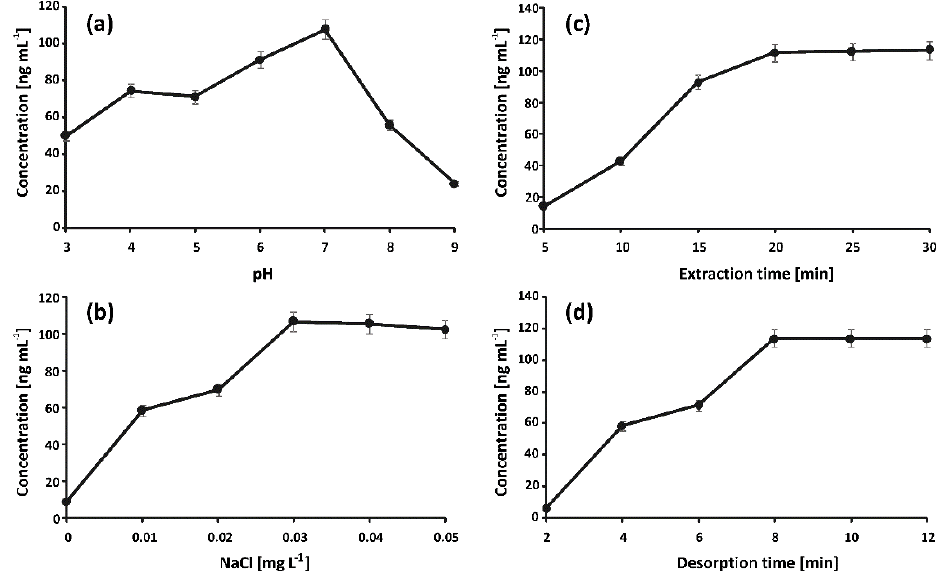
Figure 7. Effect of pH of samples ( a ), amount of NaCl ( b ), extraction time ( c ), and desorption time ( d ) on the performance of the DES-TF-SPME method. The measurements were performed using 200 mL samples containing 125 ng mL − 1 of formaldehyde derivative ( n = 4). Conditions: ( a ) Extraction time 30 min with the addition of 0.05 mg L − 1 NaCl and desorption with a mixture acetonitrile/water (90/10, v / v ) for 12 min. The pH is a variable value. ( b ) Extraction time 30 min and desorption with a mixture of acetonitrile/water (90/10, v / v ) for 12 min. The pH of the sample is adjusted to 7. The amount of NaCl is a variable value. ( c ) Extraction with the addition of 0.03 mg L − 1 NaCl and pH adjusted to 7, desorption with a mixture of acetonitrile/water (90/10, v / v ) for 12 min. The extraction time is a variable value. ( d ) Extraction time 20 min with the addition of 0.03 mg L − 1 NaCl and pH adjusted to 7, desorption with a mixture of acetonitrile/water (90/10, v / v ). The desorption time is a variable value.